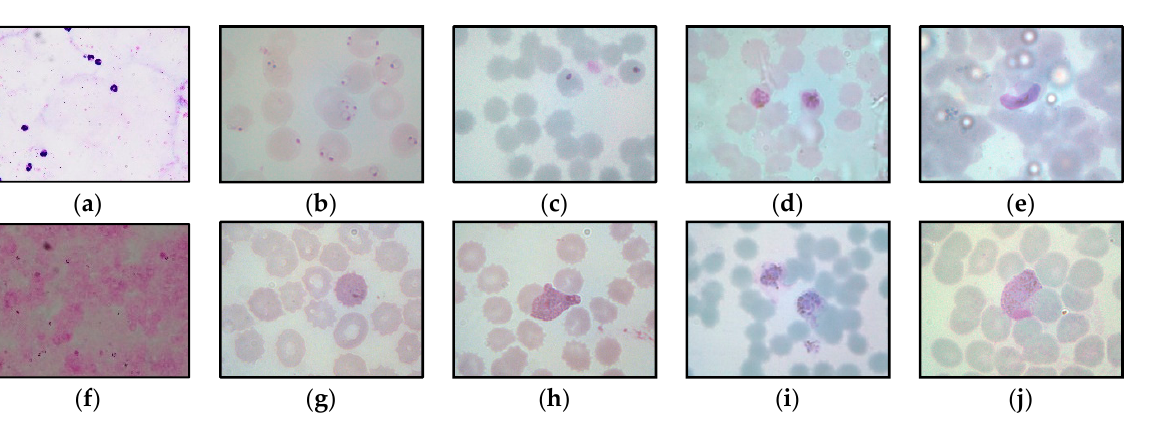
Figure 2. The samples of the captured blood images consisting of ( a ) P. falciparum of thick smear; ( b – e ) P. falciparum of thin smear in the ring, trophozoite, schizont, gametocyte; ( f ) P. vivax of thick smear; ( g – j ) P. vivax of thin smear in the ring, mature trophozoite, schizont, gametocyte.